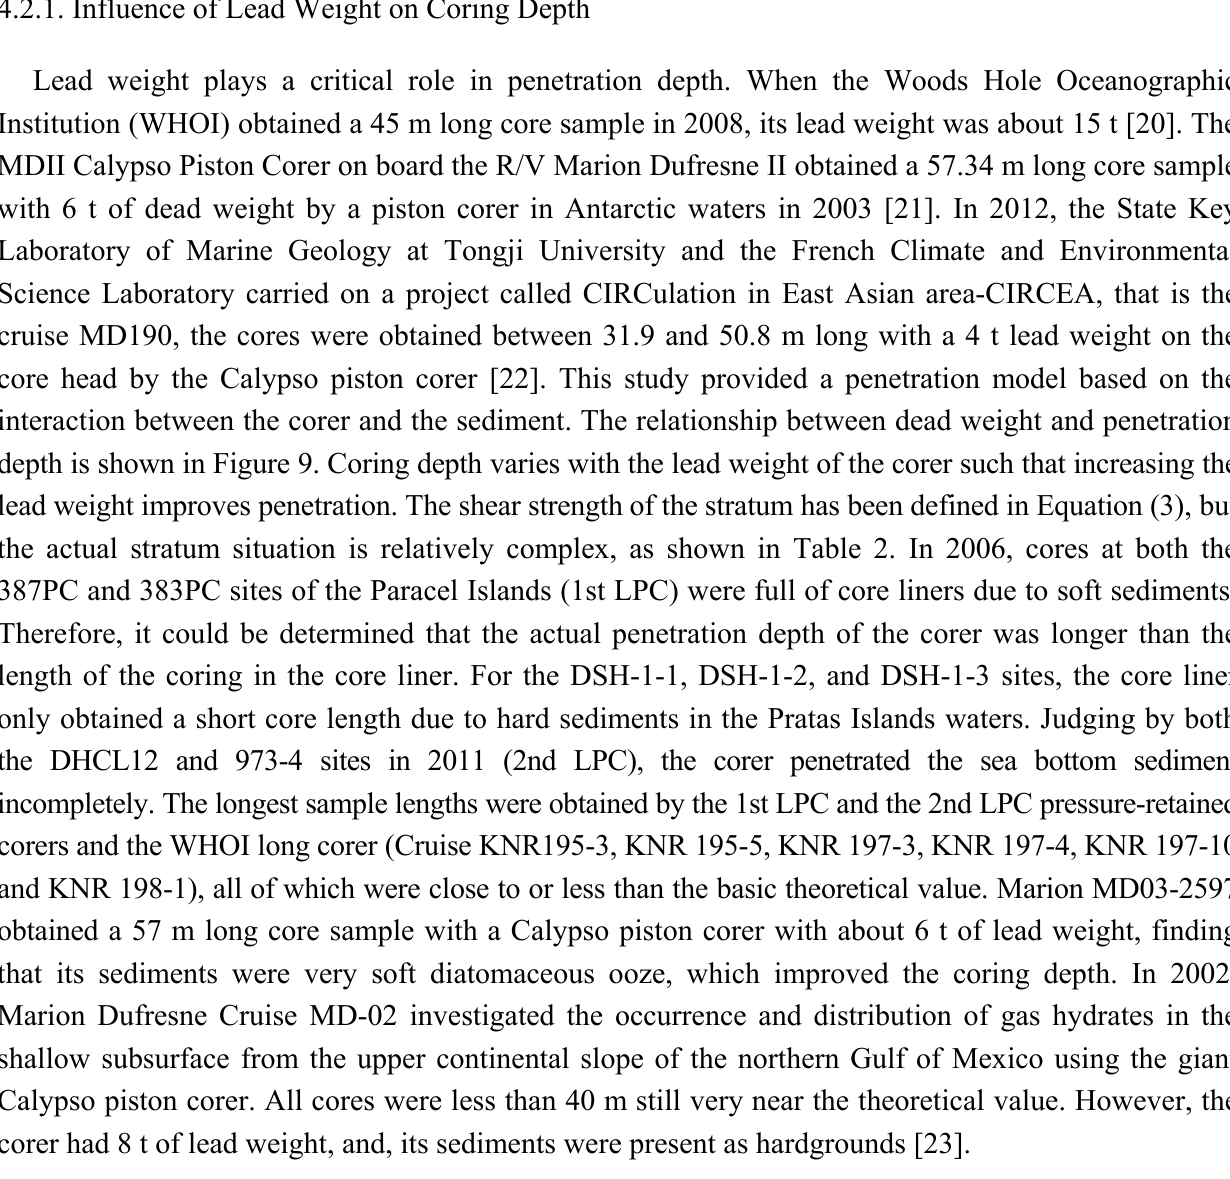
Figure 9. Relationship between load weight and penetration